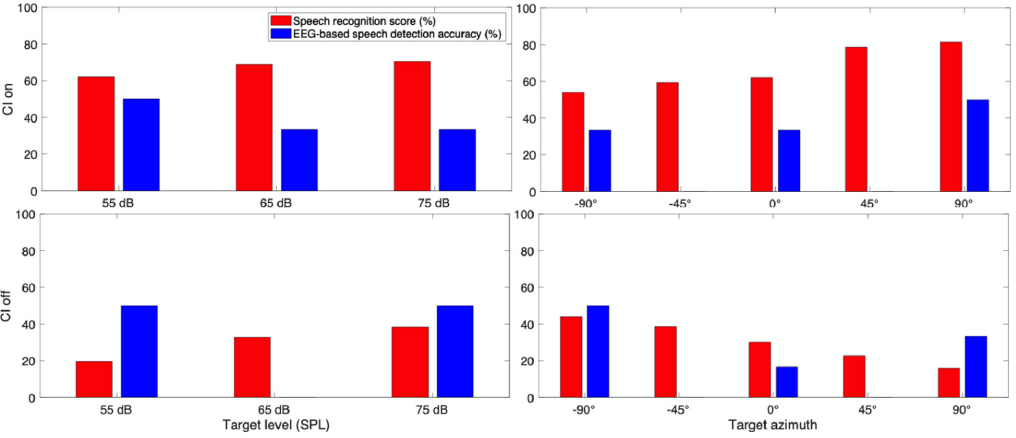
Figure 9. Speech recognition score and speech detection accuracy from EEG for CI